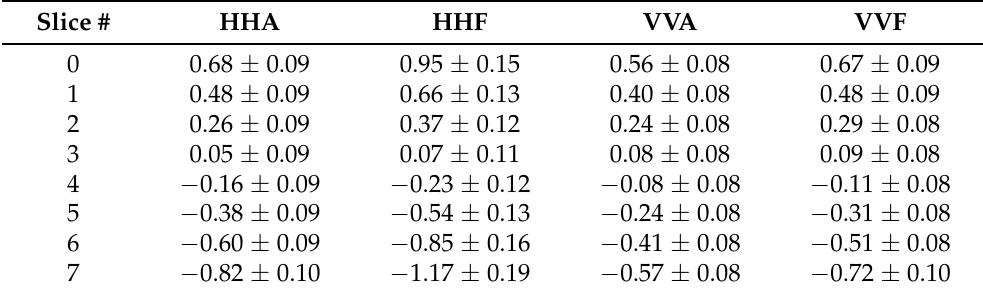
Figure 5. Solid (dashed) lines: average (maximum) intra-egg σ 0 bias in logarithmic units (dB) induced by the incidence angle variations as a function of the slice index, for the four pol-view flavors, and for the σ 0 level corresponding to 10 ms − 1 . The estimates refer to the orbit with number 40,651. WCS stands for Worst Case Scenario, while the 3-character strings in the legend represent the following: HH (VV) stands for HH-Pol (VV-Pol) and A (F) stands for aft (fore). i in the legend represents the slice index, while j represents the sample index. Table 2. Expected values of the deviations of the incidence angles of the slice with respect to the incidence angle of the egg in degrees their standard deviations for the orbit with number ±